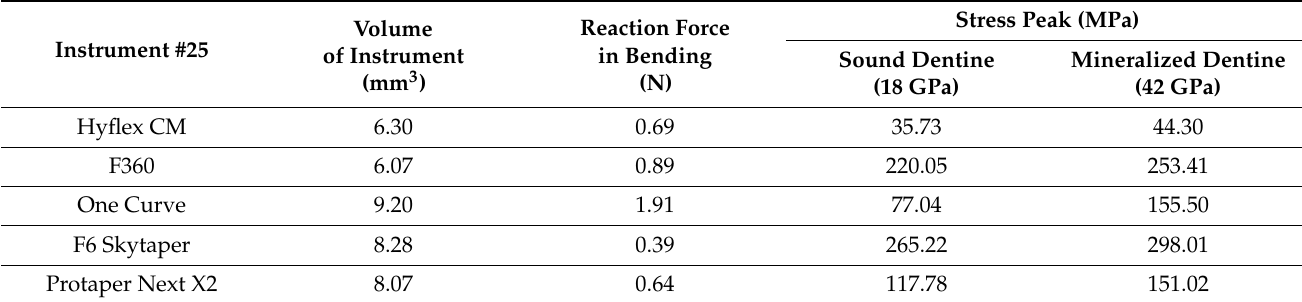
Table 2. Volume of instruments, reaction force (N) and stress peak of NiTi instruments according to the dentine elastic modulus (18 GPa and 42